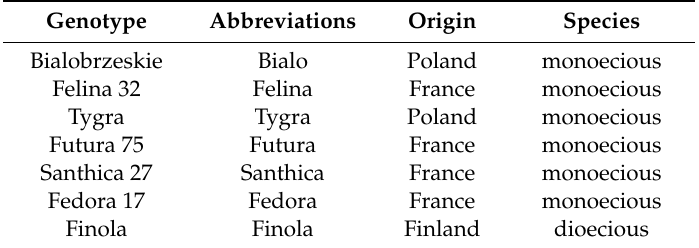
Table 1. Main characteristics of the seven industrial hemp cultivars cultivated in Greece in the present study.